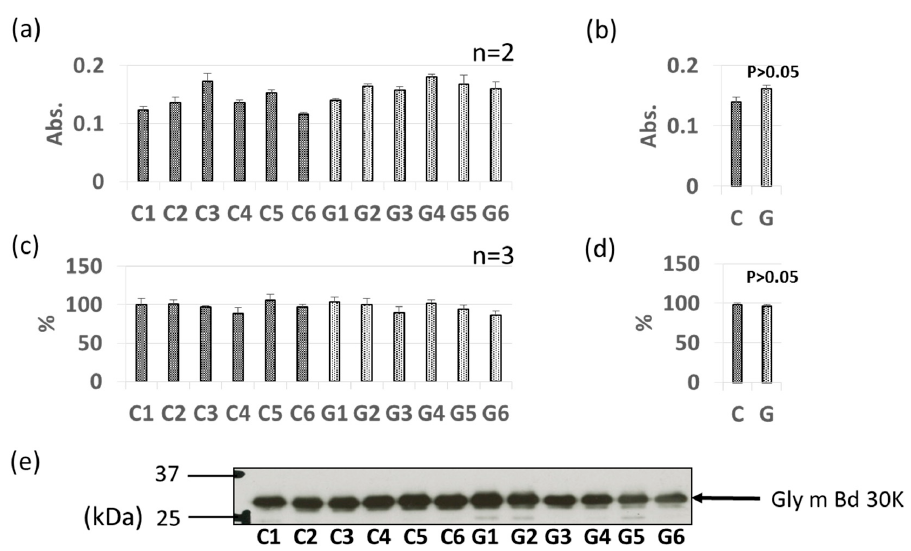
Figure 5. Comparison of trypsin inhibitor levels in GM-and non-GM soybeans by ELISA (a,b) and immunoblotting (c–e) using a rabbit-derived antibody. Soybean protein extracts were evaluated by ELISA (a,b) and immunoblotting (c–e) for detection of trypsin inhibitor levels. The ELISA data are presented in absorbance values (Abs). The individual data from six GM-and non-GM soybeans (a,c) are presented as the mean ± SD of three independent replicates. The collated data (b,d) are presented as the mean ± SD of all individual data points from the control (C1–C6, six non-GM soybeans) or experimental (G1–G6, six GM soybeans) groups relative to the value of control number 1 (C1). A representative immunoblot is also provided (e) .